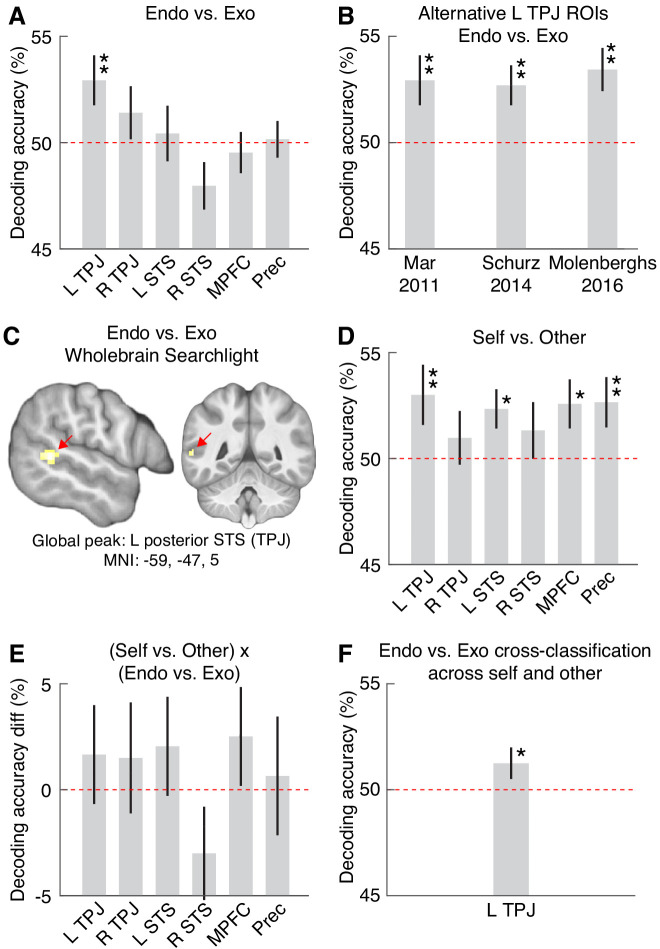
Decoding attention type, agent, and the interaction between them, in six brain areas.For definition of ROIs, see Figure 2. Each point shows mean decoding accuracy. Error bars show SEM. Red horizontal line indicates chance level decoding. Significance indicated by * (p<0.05) and ** (p<0.01), based on permutation testing (all significant p values also survived FDR correction for multiple comparisons across all six ROIs [all significant corrected ps <0.05]). (A) The ability of a classifier, trained on BOLD activity patterns within each ROI, to decode endogenous (endo) versus exogenous (exo) attention. (B) To test the robustness of the endo-versus-exo decoding in the left TPJ, we replicated the results in three ROIs derived from theory-of-mind neuroimaging meta-analyses (Mar, 2011; Molenberghs et al., 2016; Schurz et al., 2014) other than the one used for the main analysis (van Veluw and Chance, 2014) (see Figure 3—figure supplement 2 for details). (C) The cluster shown had the highest decoding accuracy in the whole-brain, searchlight analysis, for the endo-versus-exo comparison. No clusters in this analysis survived brain-wide correction for multiple comparisons. We here report clusters surviving the conventional uncorrected voxelwise threshold p<0.001, for purely descriptive purposes. See Figure 3—figure supplement 3 and Supplementary file 1 for details. (D) Decoding accuracy for agent (self versus other). (E) Decoding accuracy for the interaction between type of attention and agent. (F) The ability of a classifier, trained to discriminate attention type in self stories, to decode attention type in other stories, and vice versa (i.e. two-way cross-classification), based on activity patterns in the left TPJ ROI.